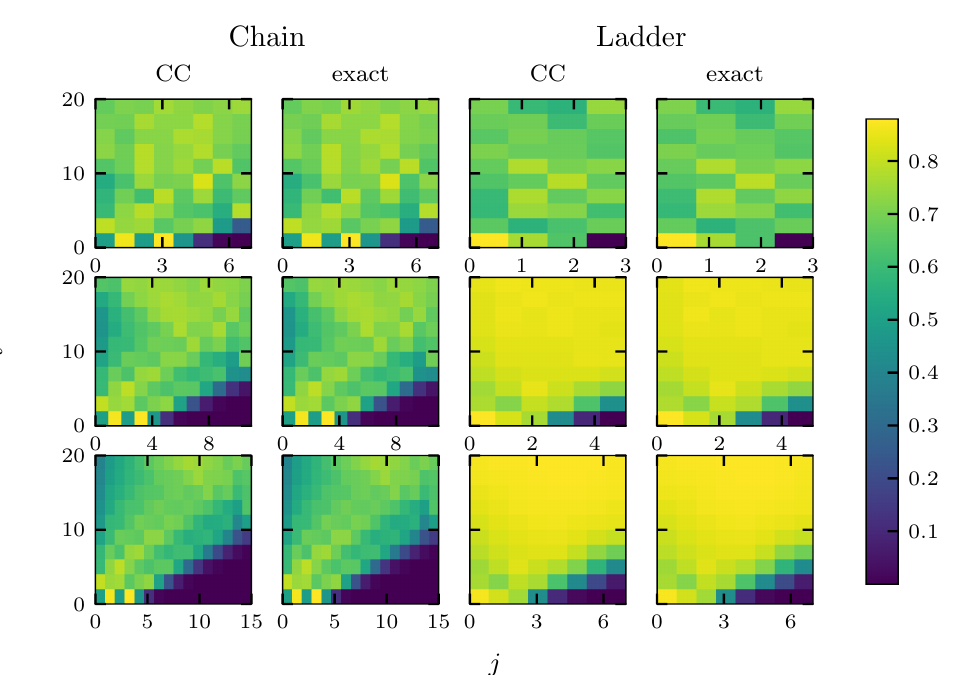
( t ) as a function of site or rung j and stacking time t Figure 14: The OTOCs C i = 2, j for the chain (left columns) and the ladder (right columns), for compressed circuits optimized at t = 2 and stacked up to ten times (first and third columns) and the corresponding target values (second and fourth columns). For the chain we take M = 8 and for the ladder M = 16. The top row is for L = 8 with χ = 256, the middle row is for L = 12 with χ = 150, and the bottom row is for L = 16 with χ =